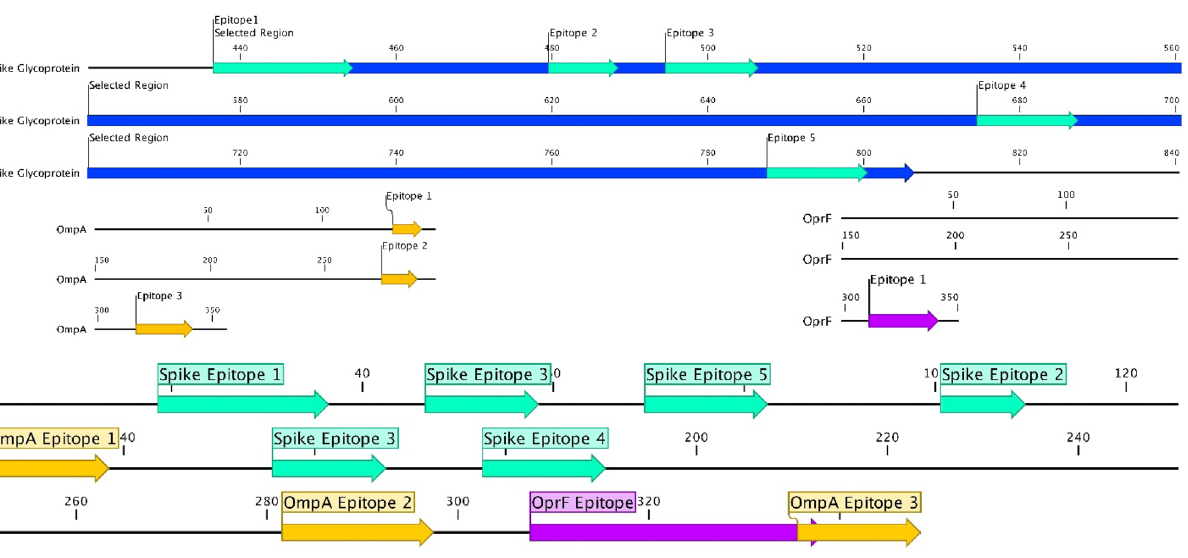
Figure 4. Construct schematics. The schematic representation of the engineered construct and the location of epitopes. Epitopes of different sources are shown in different